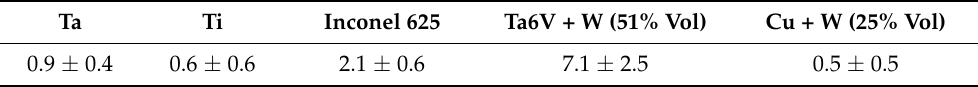
Table 3. Porosity (vol.%) achieved in individual layers.